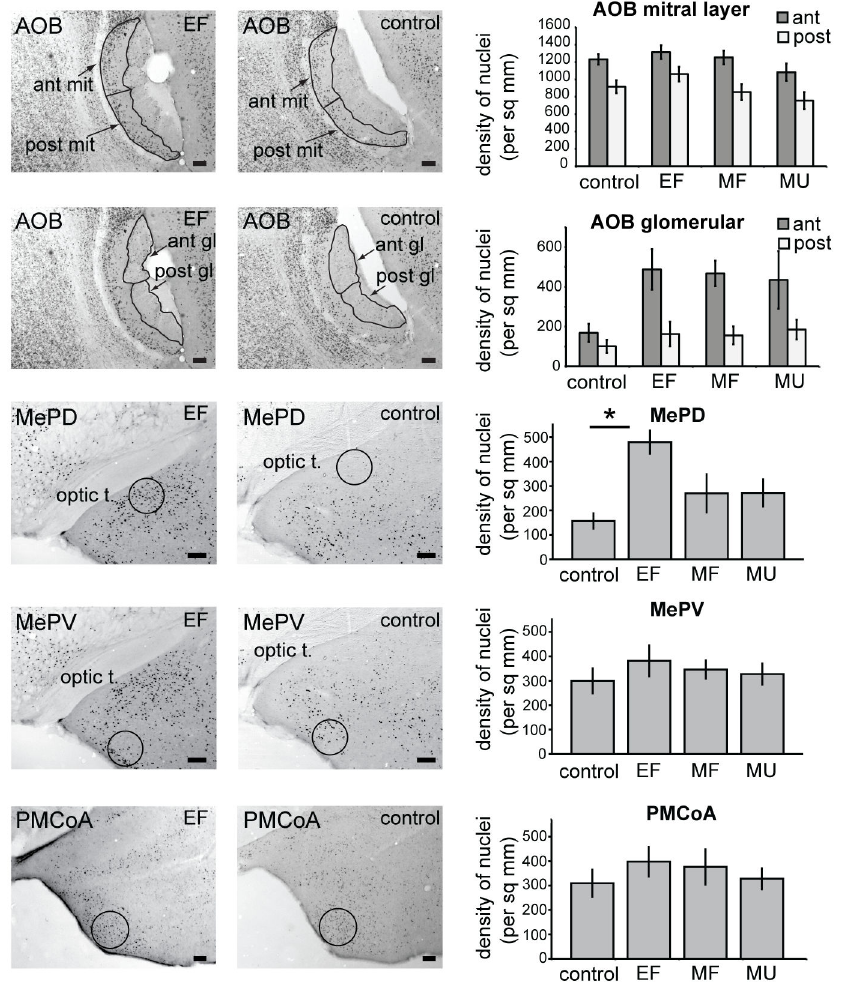
Figure 2. Lack of a differential c-Fos response to male bedding in the AOB or amygdala. Representative examples of c-Fos immunohistochemistry and the location of counting areas for non-mated females re-exposed to male bedding (EF, left) and for non- mated females exposed to clean bedding (control, centre). Right panel shows mean cell counts per mm 2 (± standard error) of c-Fos- positive nuclei in AOB and amygdala of control and EF groups, as well as groups of mated females that were re-exposed to mating male bedding (MF) or exposed to bedding from an unfamiliar strain of male (MU) two days following mating (*p < 0.05, Tukey multiple comparisons). AOB, accessory olfactory bulb (ant, anterior sub-region; post, posterior sub-region); mit, mitral cell layer; gl, glomerular layer); MePD, posterodorsal medial amygdala; MePV, posteroventral medial amygdala; PMCoA, posteromedial